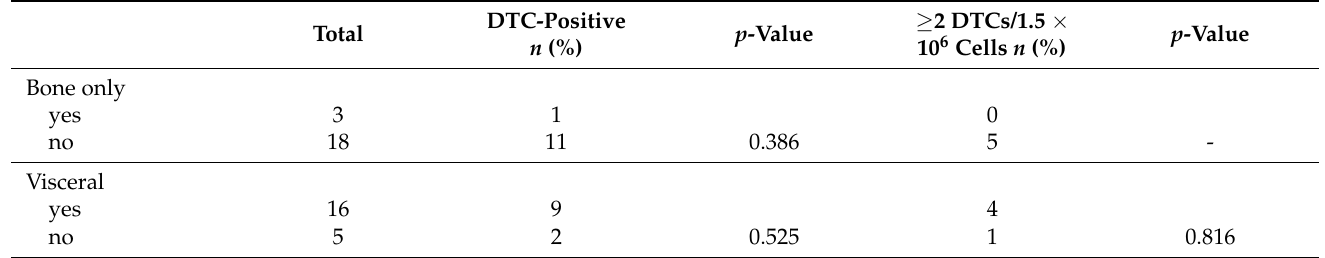
Table A2. Location of first distant recurrence in patients who received neoadjuvant chemotherapy.